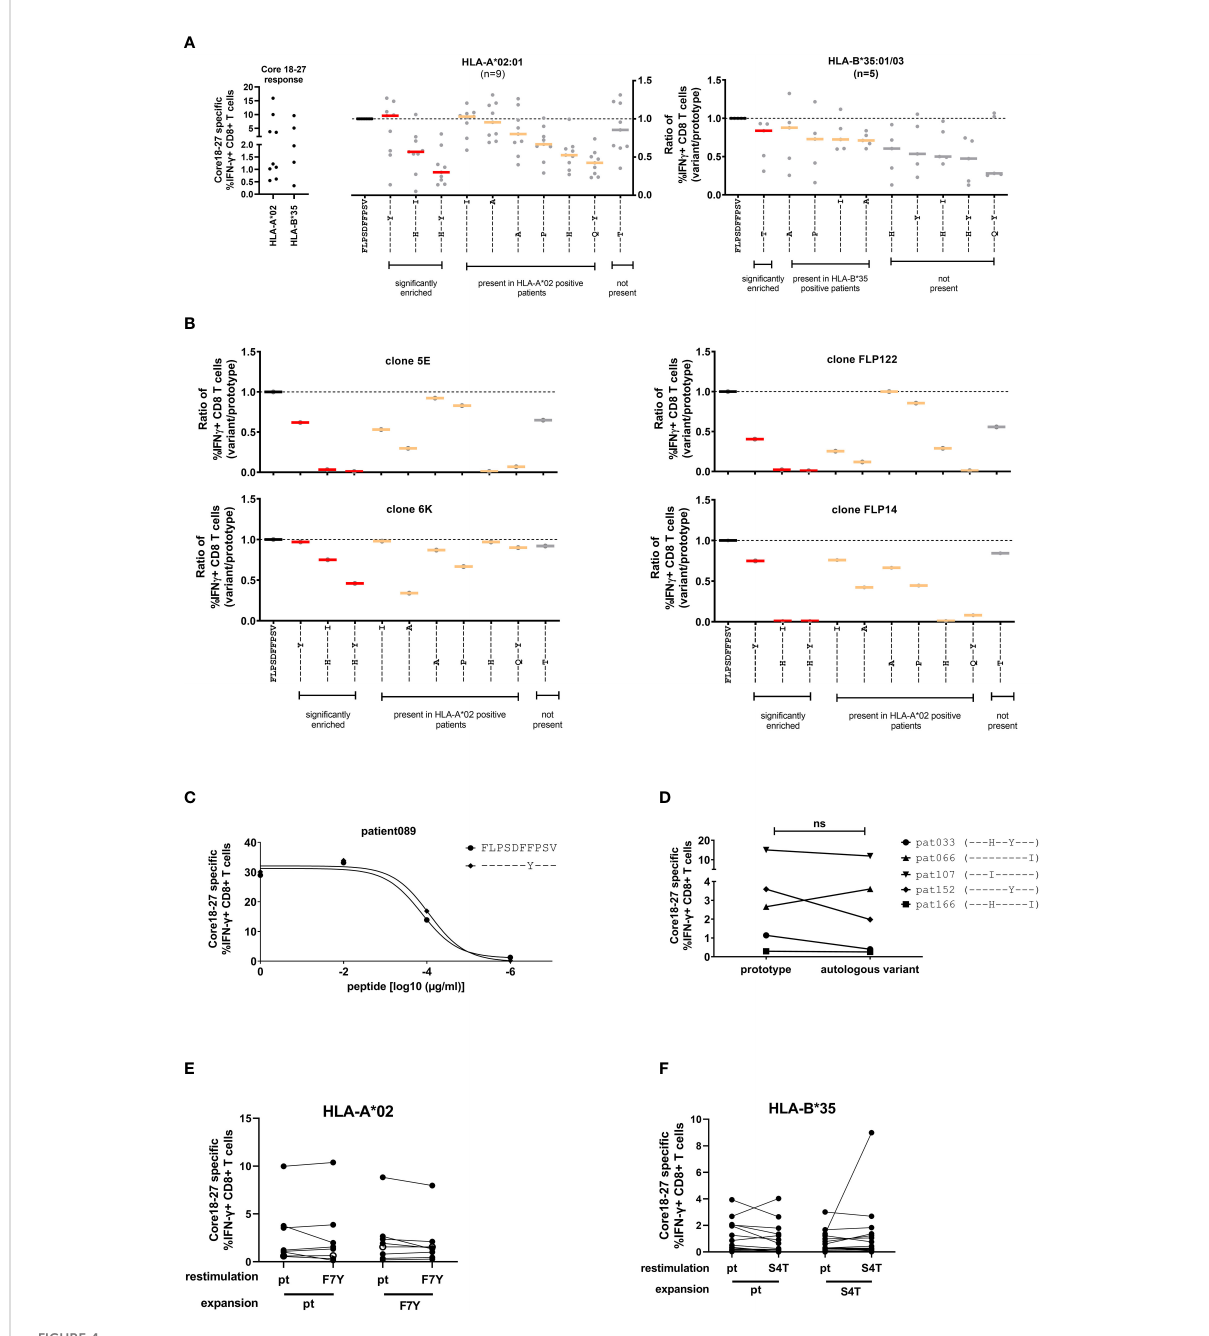
FIGURE 4 Cross-reactivity of core 18-27 -speci fi c CD8 CD8+ T cells with naturally occurring sequence variants. After antigen-speci fi c expansion for 10 days, core 18-27 -speci fi c CD8 + T cells were restimulated with the most common variants in naturally occurring isolates from Figure 2 and IFN g - producing CD8 + T cells were determined by ICS. For comparison the responses were normalized to the prototype (FLPSDFFPSV) response. (A) Left: the core 18-27 speci fi c CD8 T cell response of the patients used for the cross-reactivity analysis before normalization. Middle/Right: Cross-reactivity of core 18-27 -speci fi c CD8 + T cells with peptide variants in HLA-A*02:01 or HLA-B*35:01/03 positive patients. The response against variants with statistical support for selection on the sequence level (Figure 2) are marked in red. (B) Cross-reactivity of HLA-A*02 restricted grafted T effector cells. (C) The CD8 + T-cell response against different concentrations of the prototype peptide or the F7Y variant determined by ICS. (D) The core 18-27 CD8 + -T cell response against the prototype or the autologous viral sequence present in the corresponding patient. (E) Expansion of core 18-27 CD8 + -T cells with the prototype or F7Y-variant peptide and restimulation with the indicated peptide in HLA-A*02 positive patients (n=8) (F) Expansion of core 18-27 CD8 + -T cells with the prototype or S4T-variant peptide and restimulation with the indicated peptide in HLA-B*35 positive patients (n=20). ns = not signi fi cant p